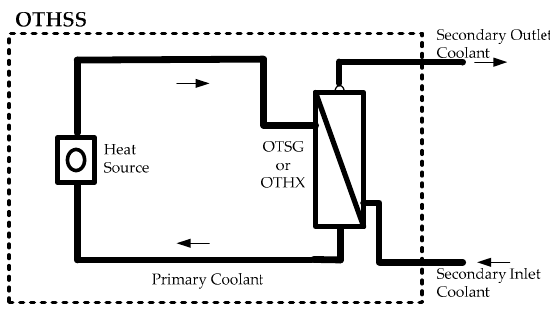
Figure 1. Schematic diagram of a once-through heat supply system (OTHSS) module.